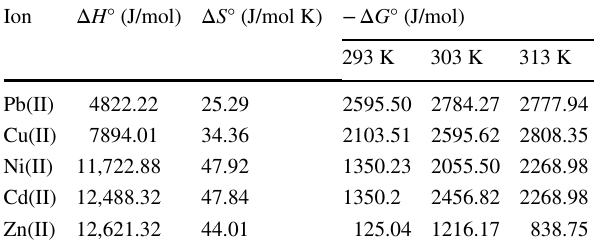
Table 5 Thermodynamic parameters for the adsorption of heavy met- als onto chitin at various temperatures